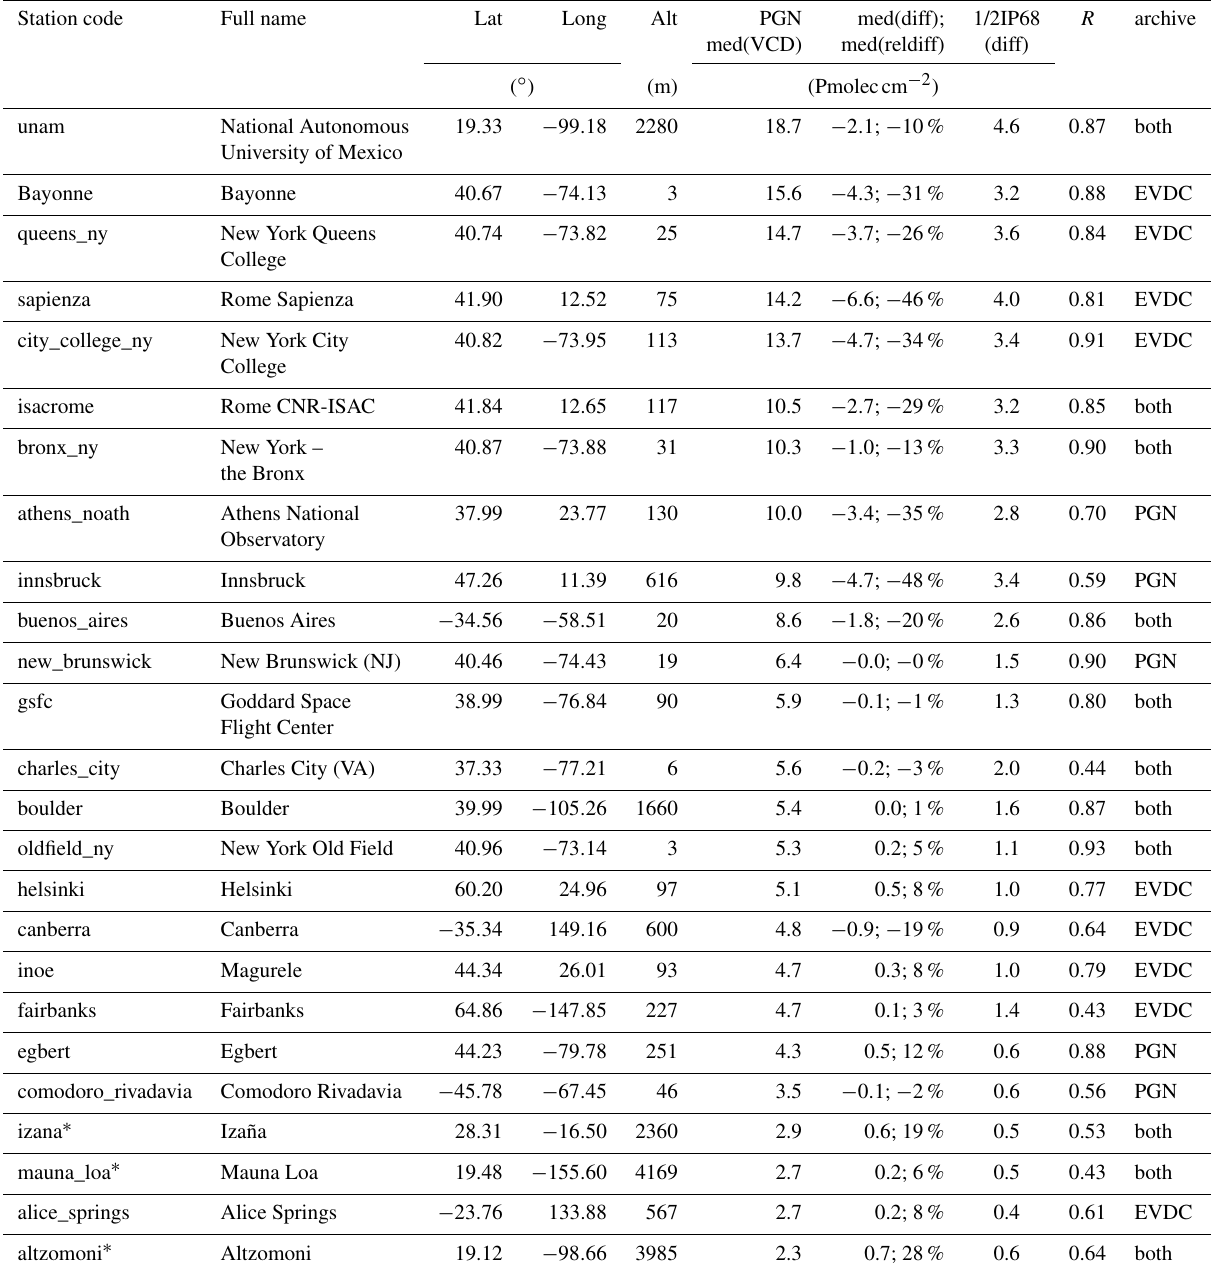
Table A3. PGN stations, ordered by median PGN NO 2 column value, that contribute to the total NO 2 validation. Mountaintop stations (not sensitive to lower lying tropospheric NO 2 ) are marked with an asterisk. In the last row, we indicate where the data can be obtained (EVDC or directly from the PGN website). Note that only PGN data from a recent quality upgrade (with file version 004 or 005, where 005 has precedence) was used. The bias over all stations (median over all station medians) is − 0 . 5Pmoleccm − 2 ( − 7%), while the overall